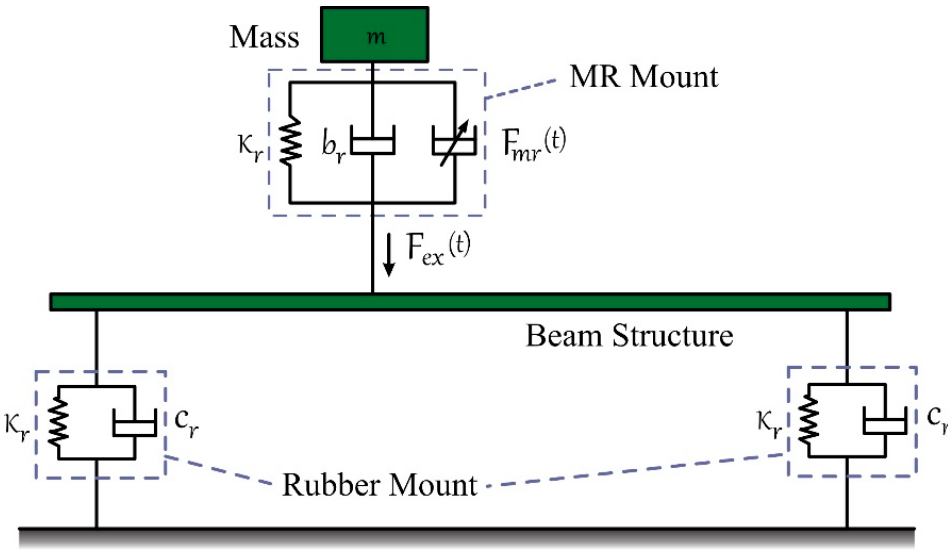
Figure 19. Configuration of the structural system with the MR mount [189].